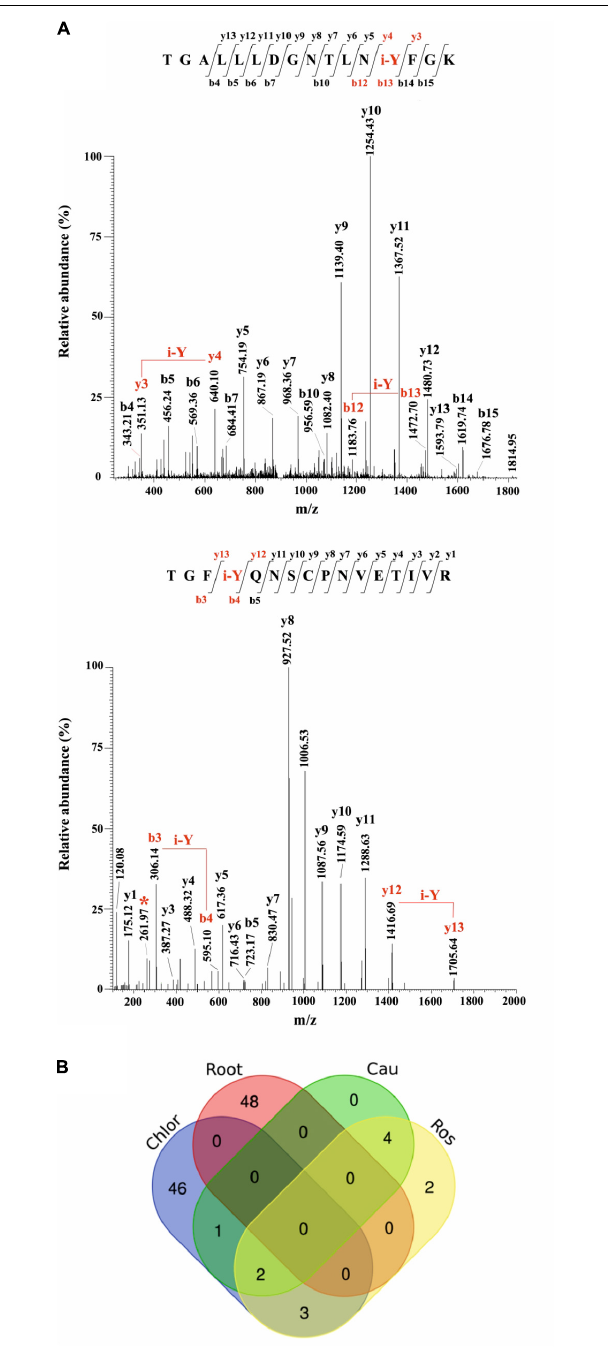
FIGURE 6 | Iodination in A. thaliana proteins identified by database searching of nano-LC-ESI-MS/MS raw data from a public repository (PRIDE). (A) Unambiguous assignment of iodination sites by MS/MS analysis in two peptides from chloroplast (light harvesting complex of photosystem II 5, AT4G10340.1), upper panel, and roots (peroxidase superfamily protein, AT4G30170.1), lower panel. The peptides are identified by both y, and b ions. Red labels in the spectra evidence the mass shift corresponding to the iodinated tyrosine (i-Y). (B) Venn Diagram showing the iodinated peptide sequences identified in the datasets of chloroplasts (Chlor), cauline (Cau), rosette (Ros), and roots